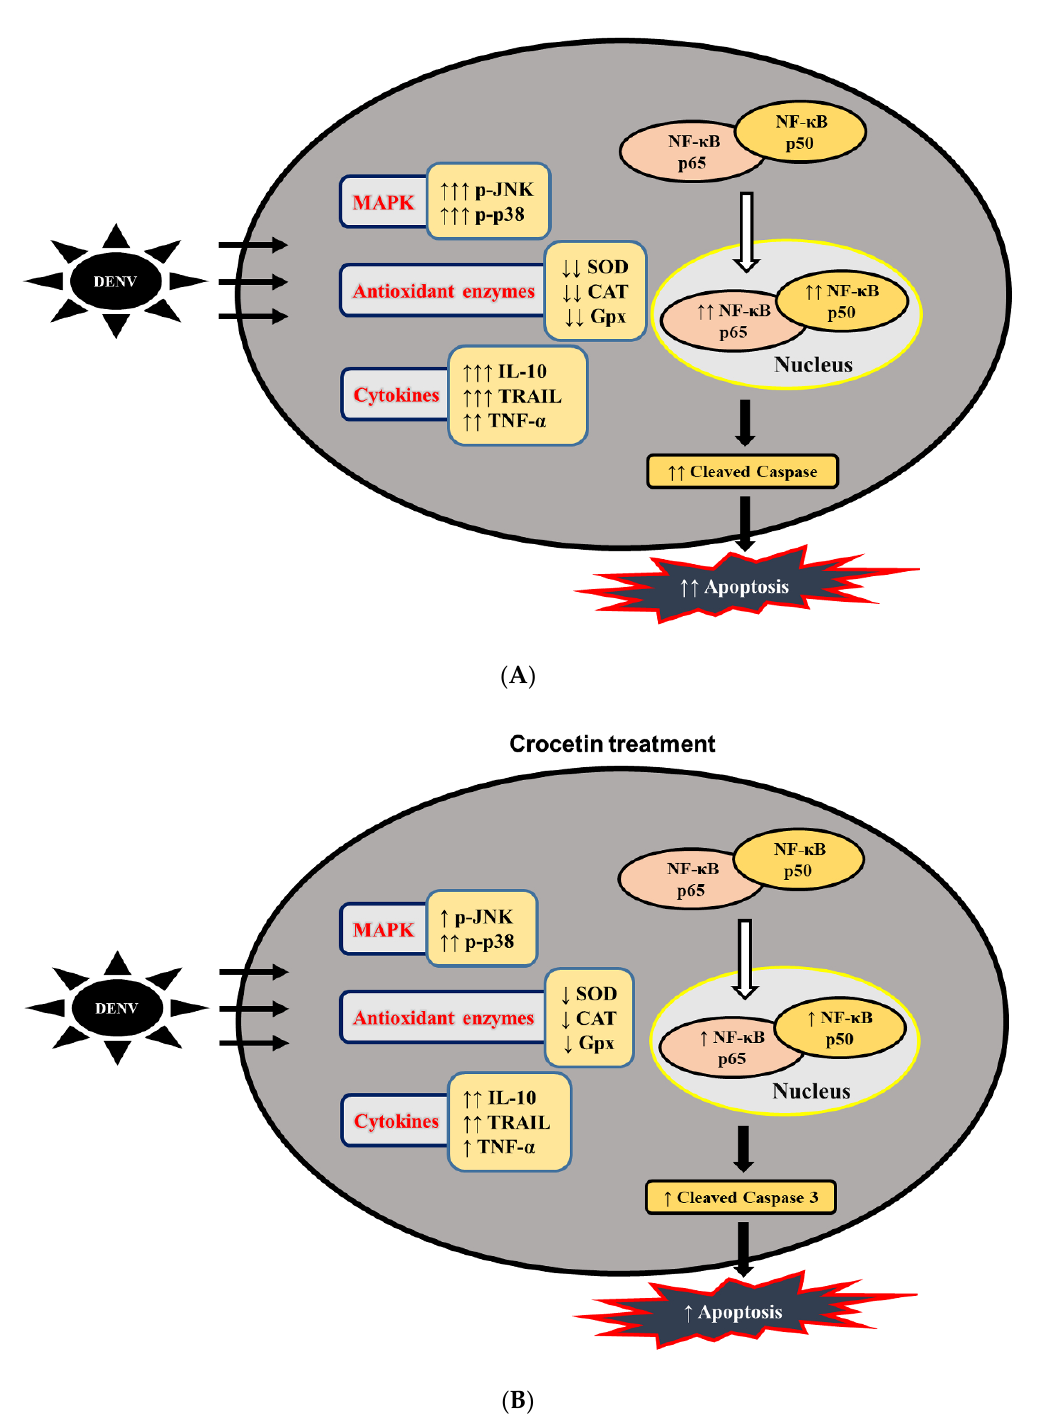
Figure 9. Flow diagram explaining the proposed mechanism of action of crocetin treatment in DENV-infected mice. ( A ) without crocetin treatment, and ( B ) with crocetin treatment.